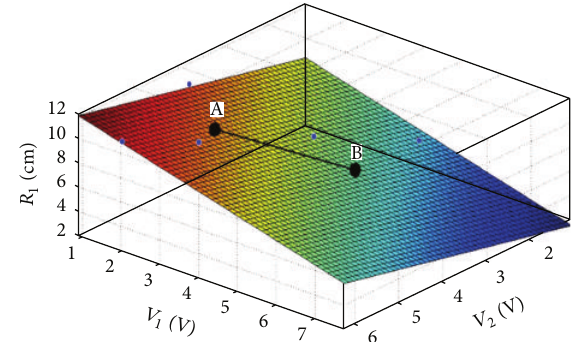
Figure 19: Distance of the impact point from sensor 1 ( 𝑅 1 ) versus the two output voltages from the two sensors ( 𝑉 1 and 𝑉 2 ).